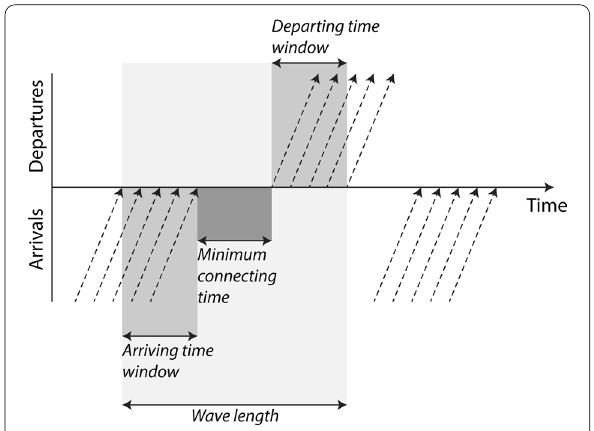
Fig. 1 Theoretical configuration of a wave-system structure (adapted from [15,